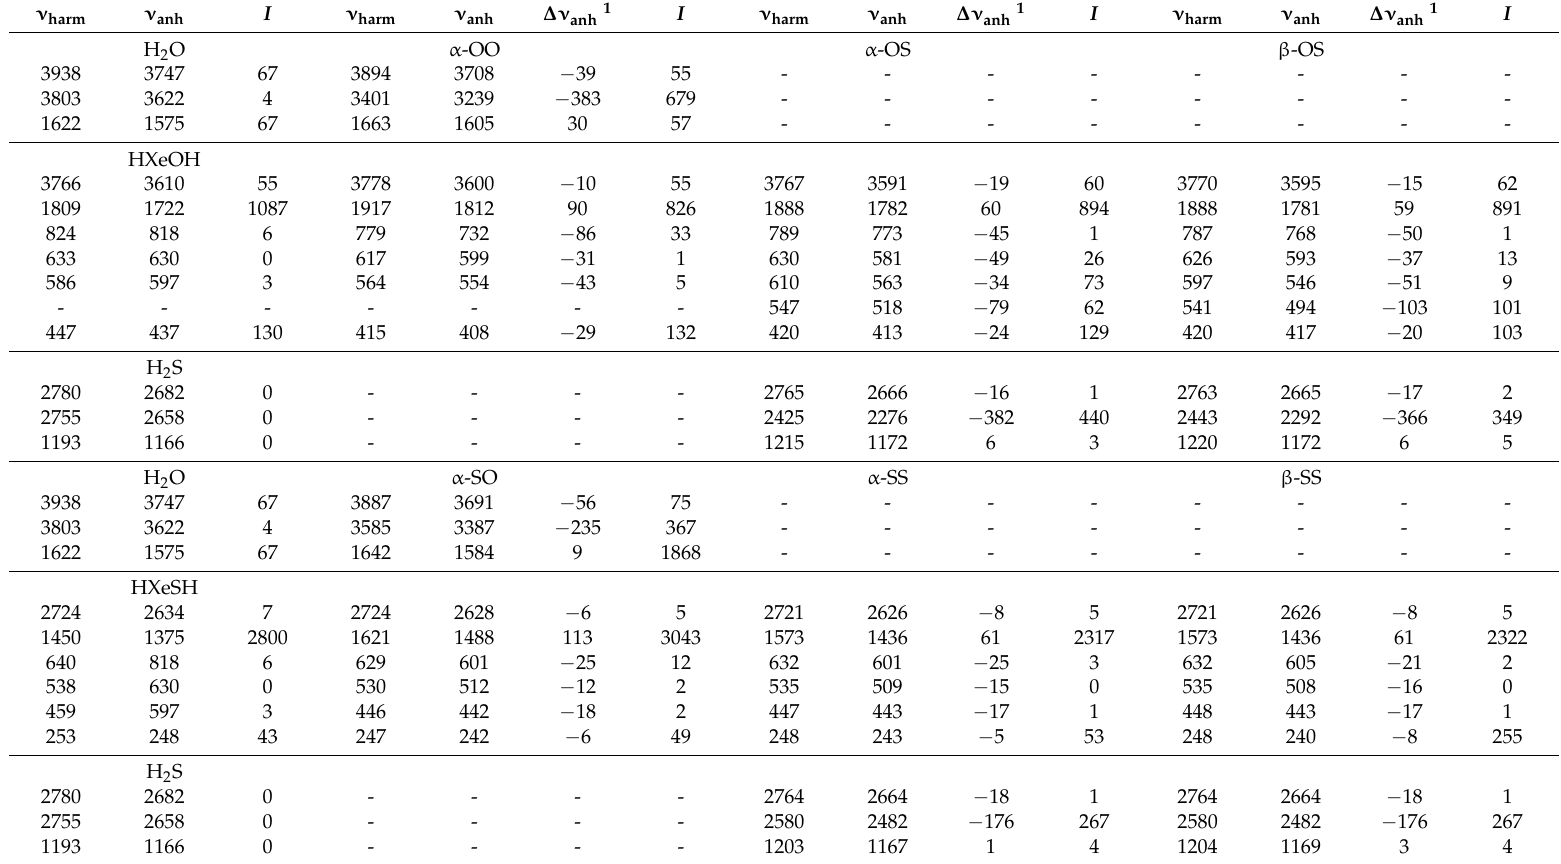
Table 2. The harmonic and anharmonic fundamental mode wavenumbers (in cm − 1 ) and their infrared intensities (in km · mol − 1 ) of the most stable complexes compared with their isolated subunits. All calculations were performed on the MP2/aug-cc-pVDZ(-PP) level of